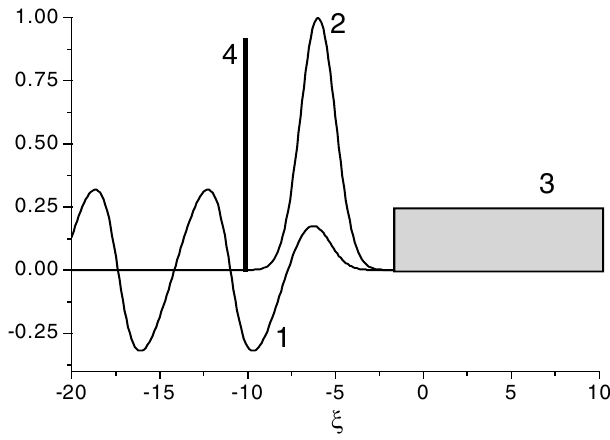
FIG. 1. The novel injection method. The normalized longitu- dinal (accelerating) component of the laser wakefield E (curve 1), and the laser pulse intensity profile (curve 2). Areas 3 and 4 schematically show the initial and trapped electron bunches,